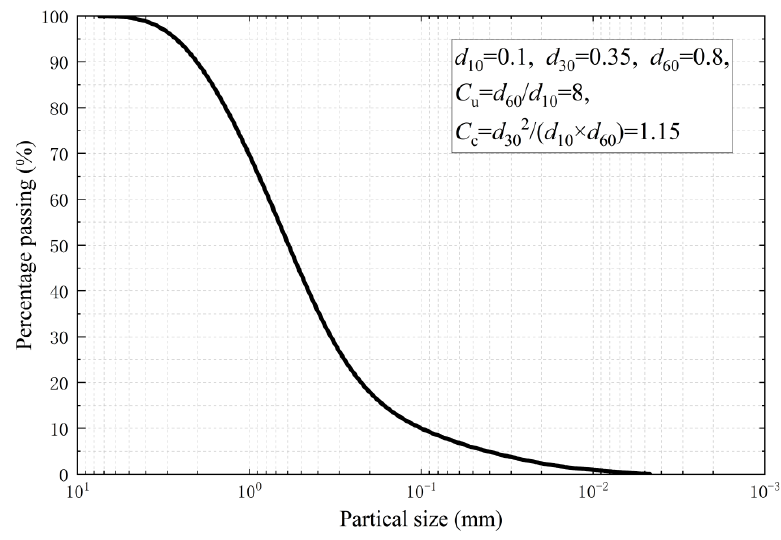
Figure 2. XRD-ray diffraction pattern.